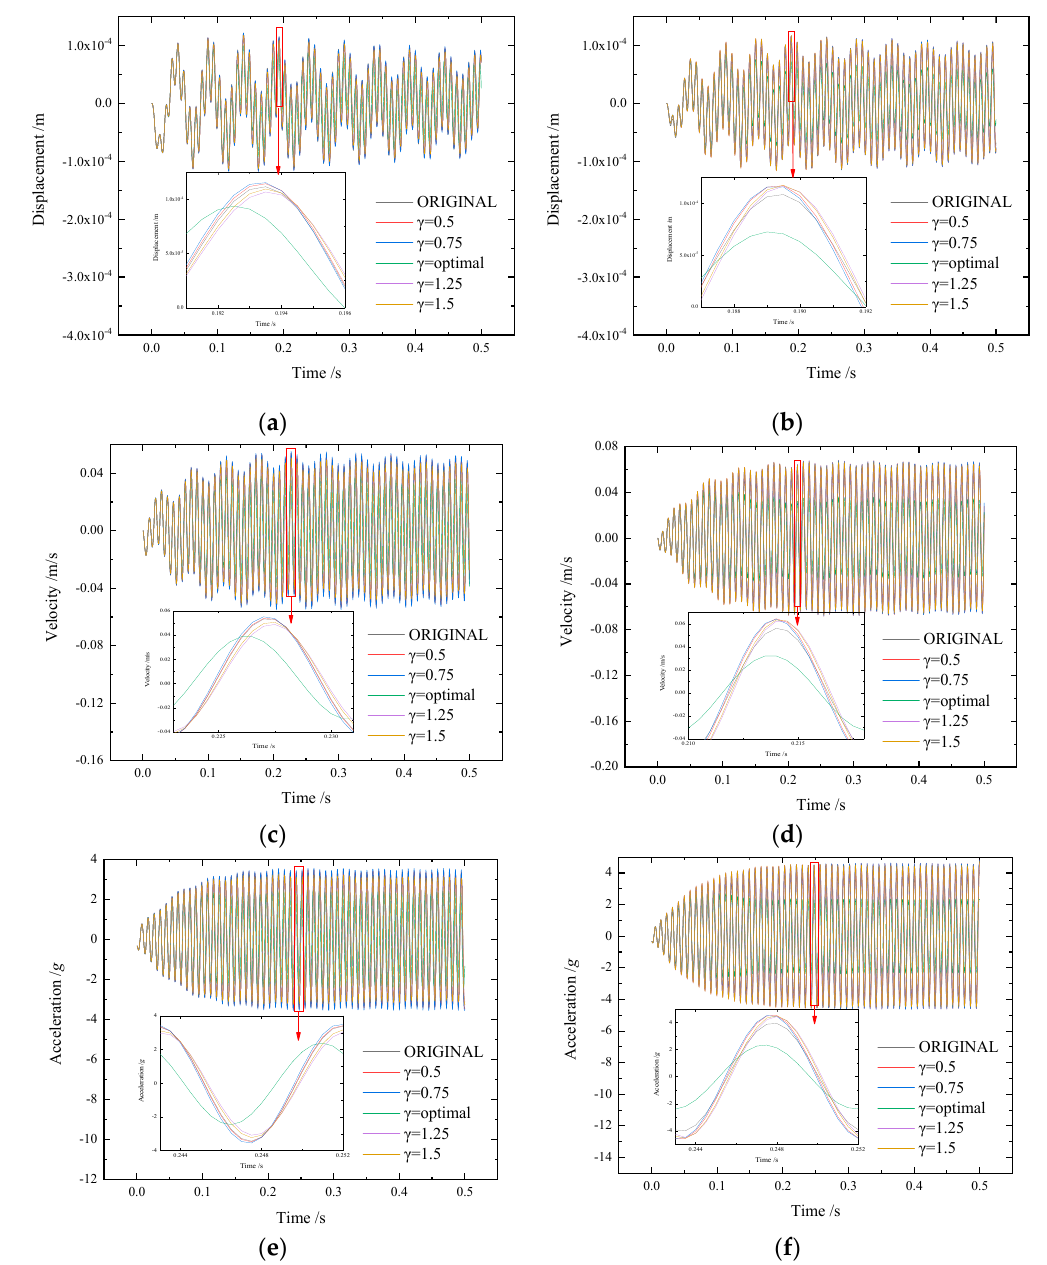
Figure 11. Comparison of time history curves at different tuning ratios: ( a ) displacement time history curve of the top structure; ( b ) displacement time history curve of the bottom structure; ( c ) velocity time history curve of the top structure; ( d ) velocity time history curve of the bottom structure; ( e ) acceleration time history curve of the top structure; and ( f ) acceleration time history curve of the bottom structure.